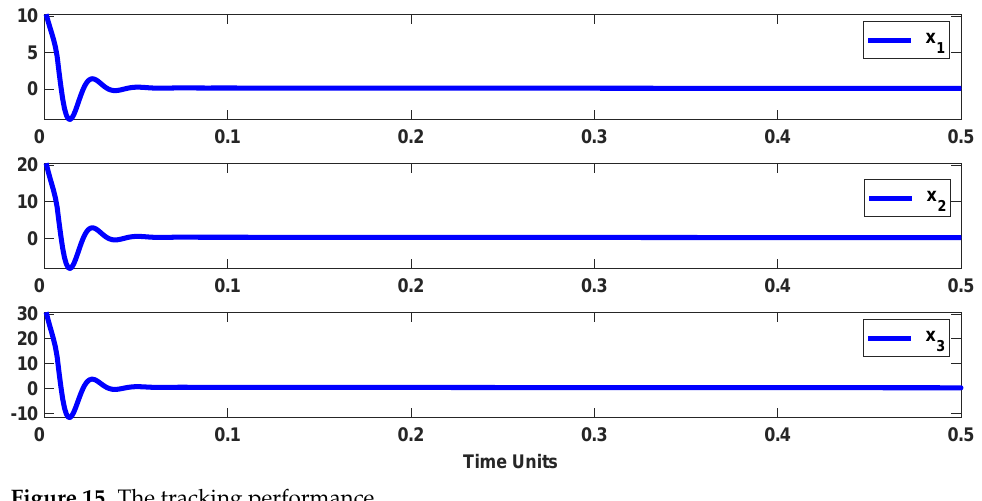
Figure 15. The tracking performance. Table 3. RMSE and ISE comparisons. FOC [48] FTAC [48]